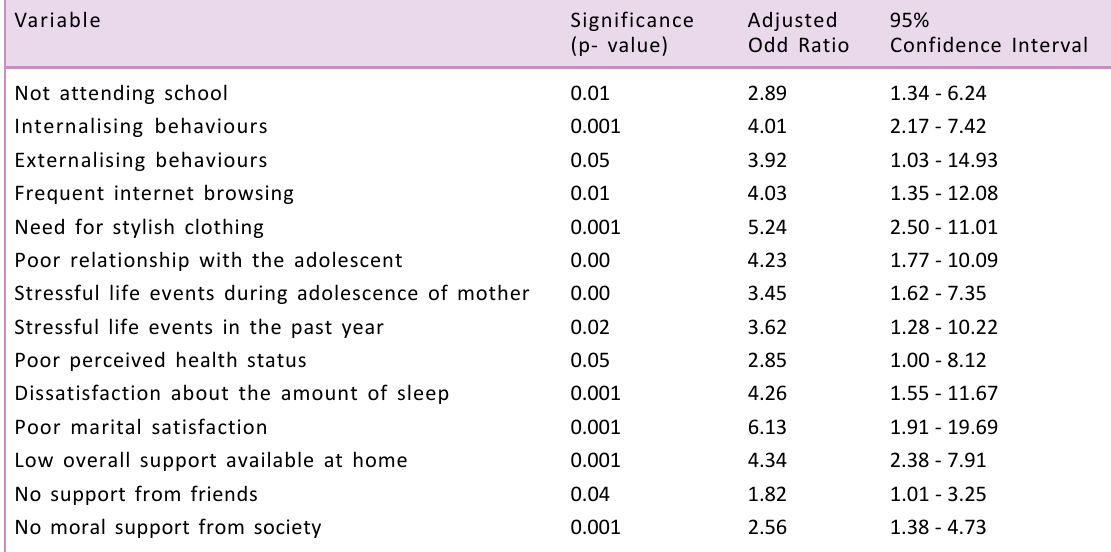
Table 1. Risk factors of parenting stress among mothers of adolescents, identified by the logistic regression